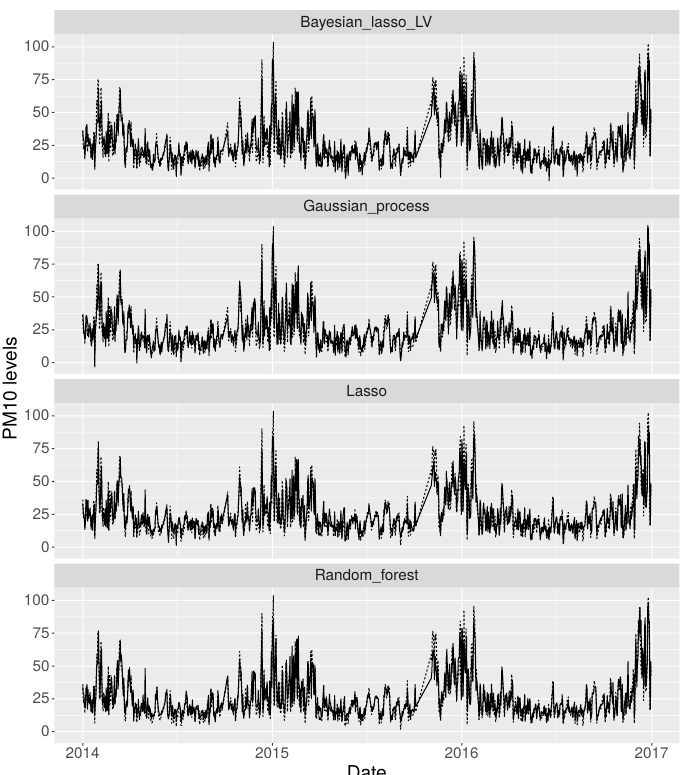
Figure A1. Observed and predicted PM 10 levels by different models for today for Ljubljana. The dashed line represents the observed